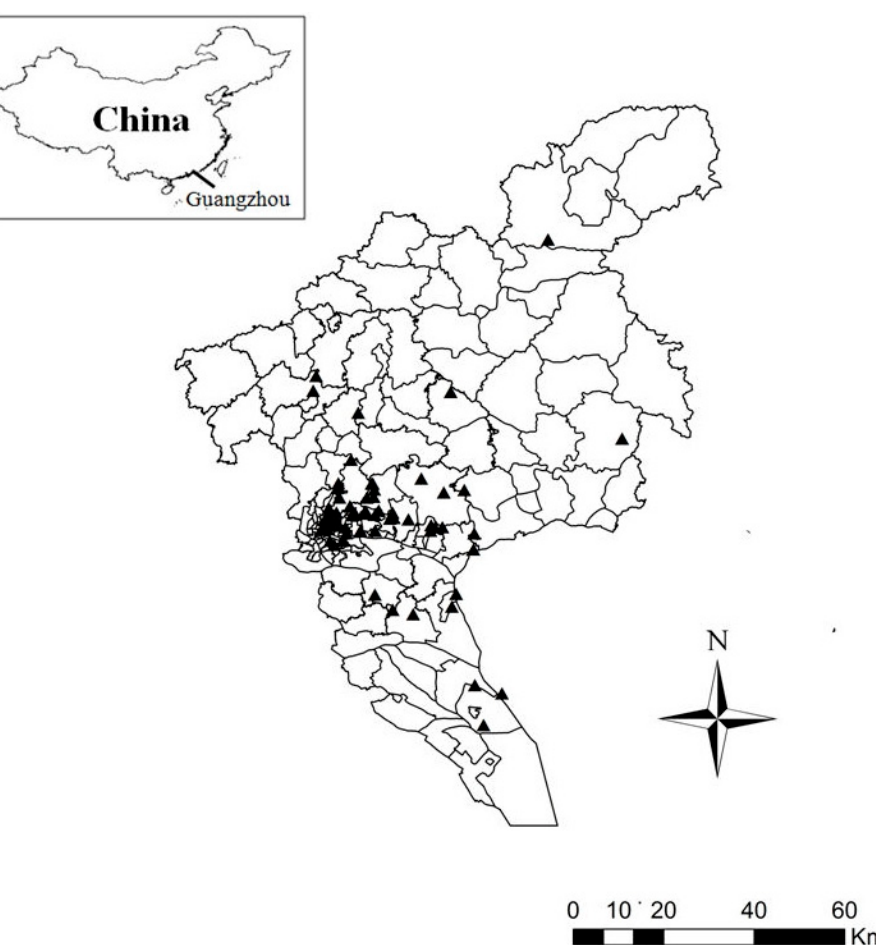
Figure 1. Geographical distribution of sentinel hospitals for stroke events monitoring in Guangzhou during the time period of 2013–2015. Located on the Pearl River Delta Area, Guangzhou is the capital and largest urban setting of Guangdong province, south China.